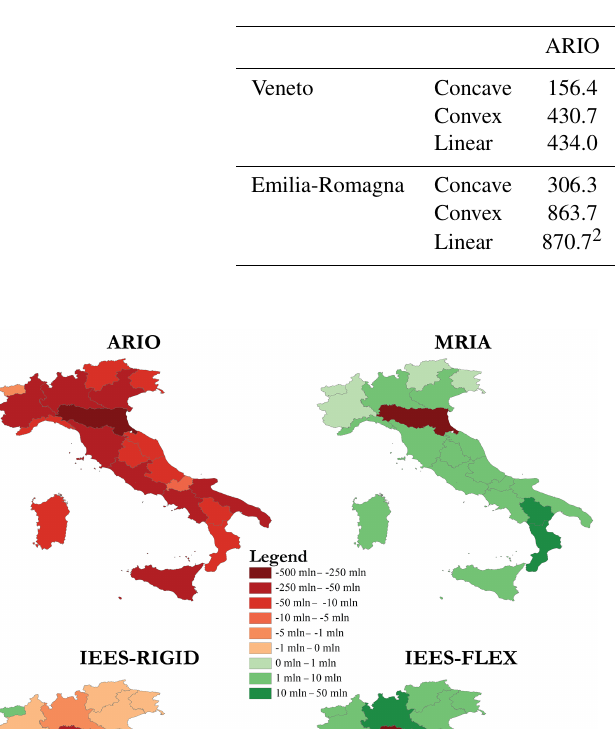
Table 5. Economic losses for the affected regions under all model set-ups (in million Euro).